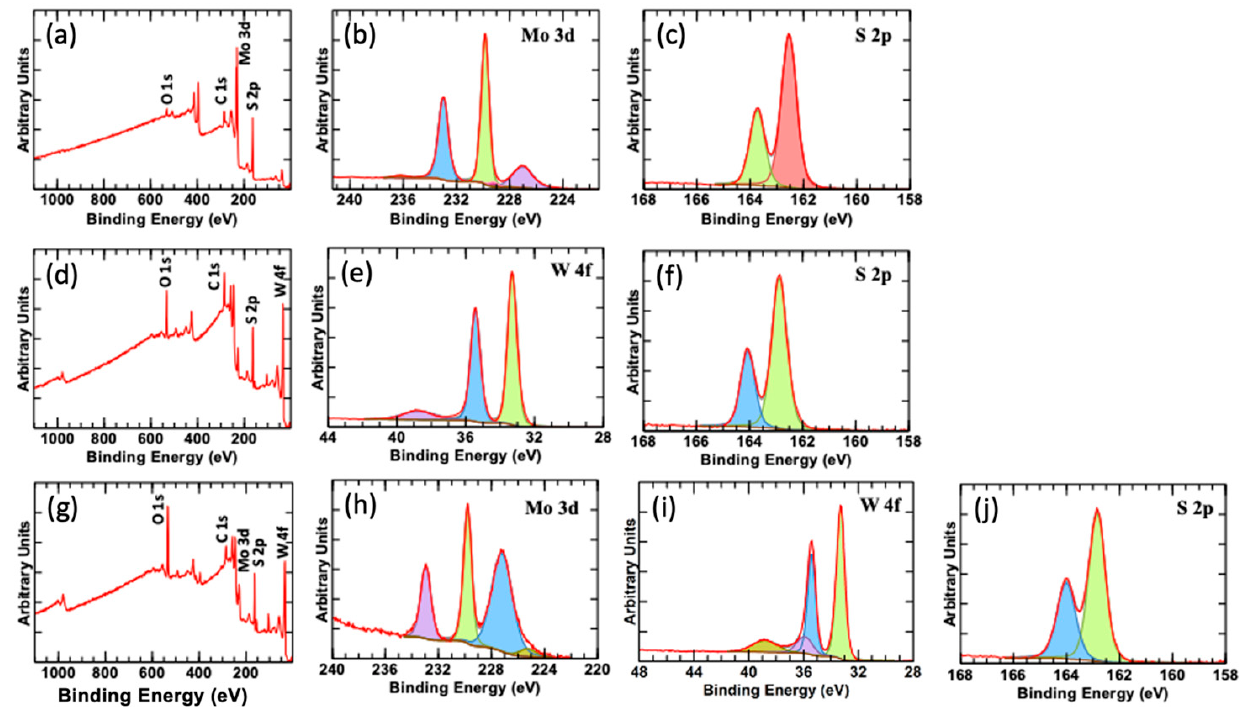
Figure 6. XPS analyses for the ( a – c ) MoS 2 , ( d – f ) WS 2 and ( g – j ) Mo x W 1-x S 2 samples.